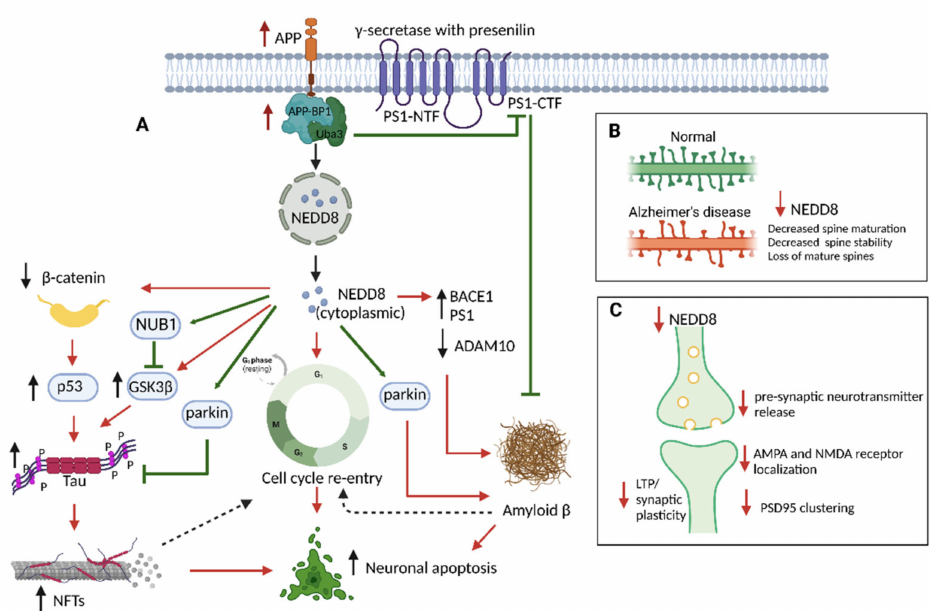
Figure 2. Role of neddylation in Alzheimer’s disease. ( A ) Increased expression of APP leads to upregulation of APP-BP1 and NEDD8 translocation from the nucleus to cytoplasm leading to cell cycle re-entry and apoptosis of neurons. The downstream effects of cytoplasmic NEDD8 include downregulation of β -catenin with an associated increase in p53, GSK3 β , BACE1, and PS1 leading to tau hyperphosphorylation and A β . NEDD8 activates NUB1, which inhibits GSK3 β and tau hyper- phosphorylation. NEDD8 interacts with parkin and increases the ubiquitination of p-Tau and A β . Red arrows indicate detrimental and green arrows indicate a protective effect. ( B ) Downregulation of NEDD8 affects spine maturation, spine stability, and loss of mature spines in AD. ( C ) Downreg- ulation of NEDD8 impairs the presynaptic and postsynaptic expression and function, leading to impaired synaptic neurotransmission. Abbreviations: A β —Amyloid beta; APP—Amyloid